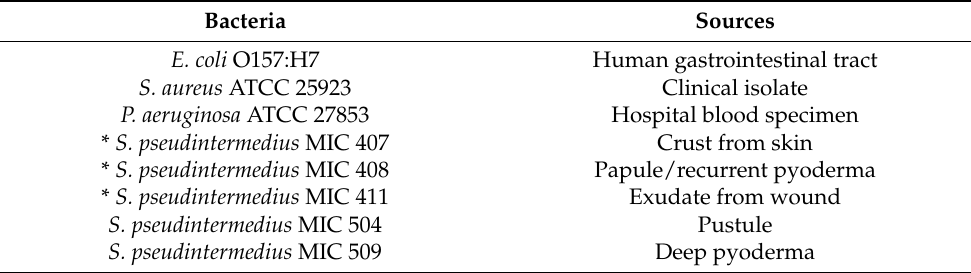
Table 1. Bacteria used in this